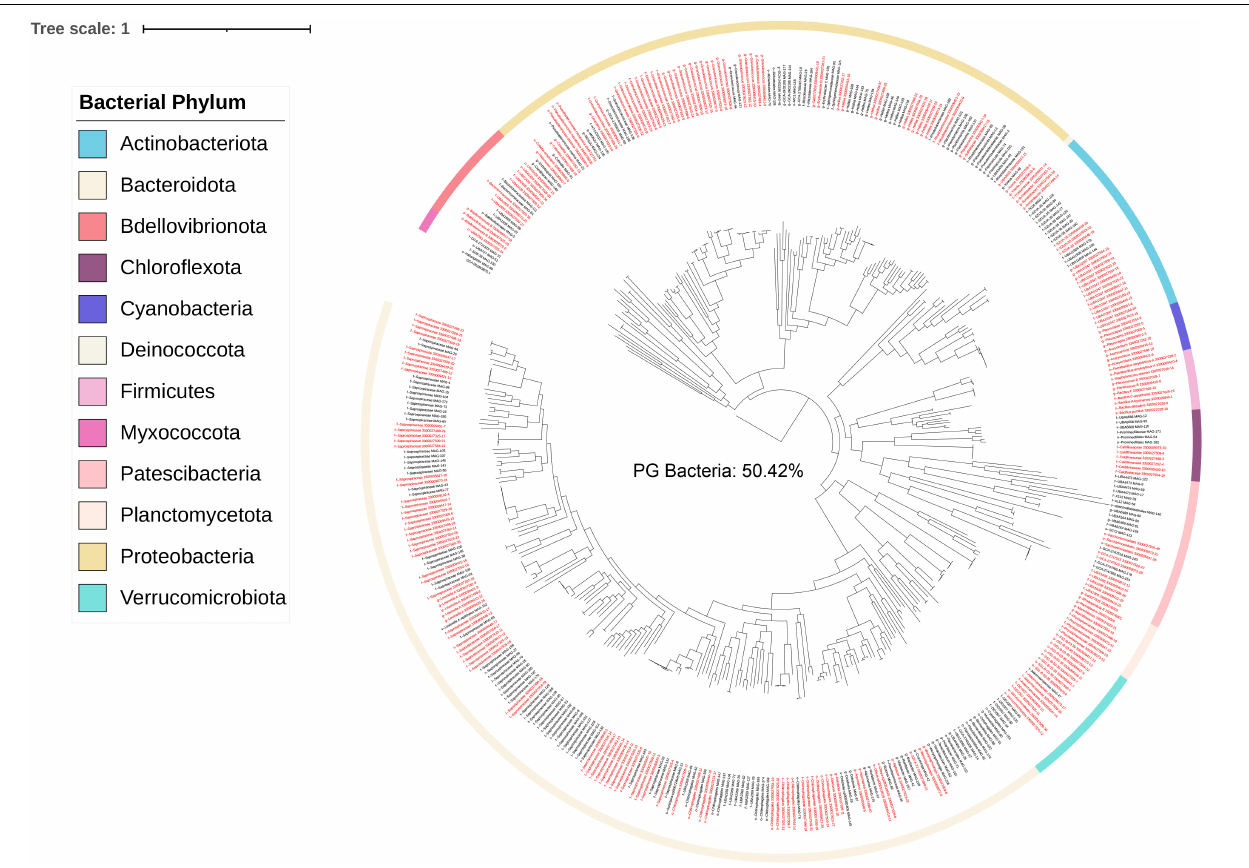
FIGURE 2 | Bacterial phylogenetic tree based on single copy marker proteins (inferred with GTDB). Labels in red are MAGs retrieved from this study. Black labels are Pyropia isolated genomes in the IMG/M database. Branch labels display taxonomy at the lowest inferred level. The phylogenetic tree was rooted to “GCA-002453875.1” by GTDB-Tk v1.3.0.